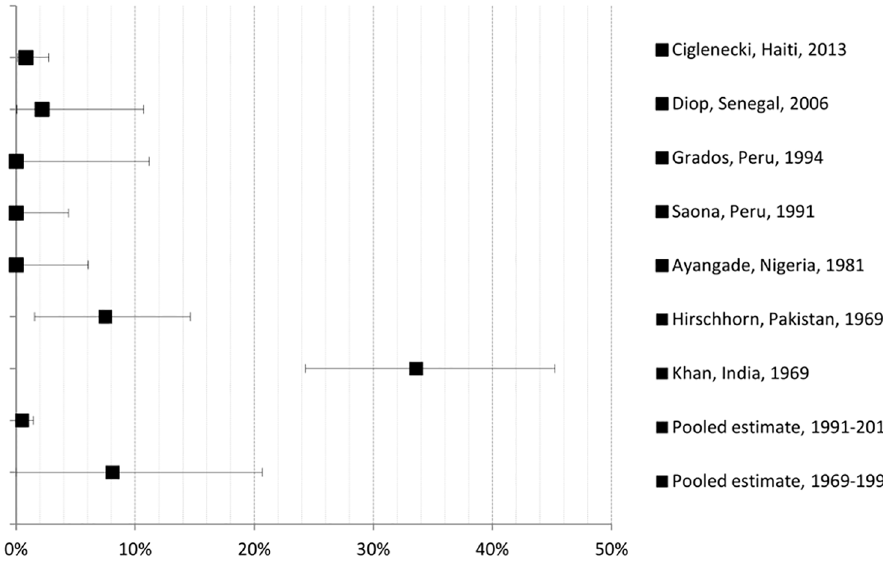
Fig 3. Neonatal death rate with maternal cholera: study and pooled estimates per 100 pregnancies with 95% confidence intervals.